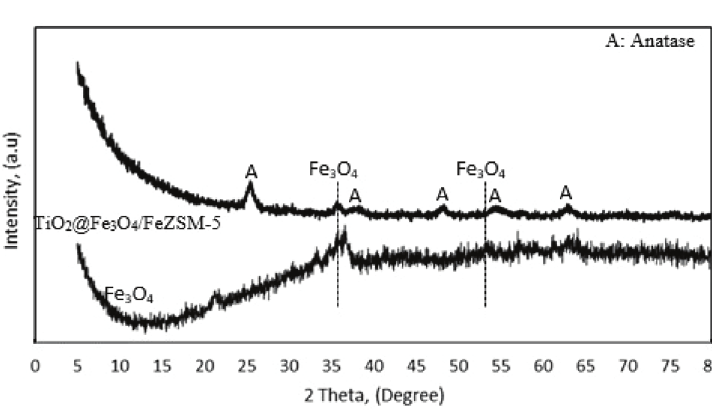
@Fe O /FeZSM-5 particles 2 3 4